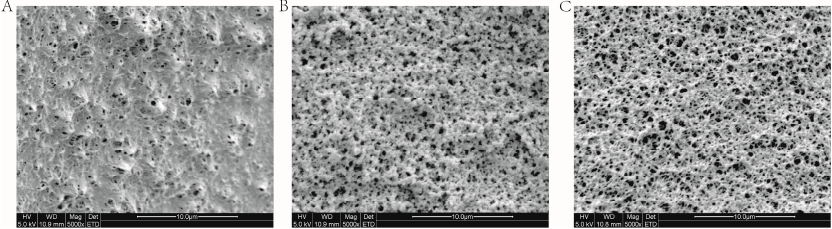
Figure 2. SEM images of ( A ) pure chitosan particles; ( B ) glutaraldehyde activated particles; and ( C ) Sortase A (SrtA) immobilized particles.